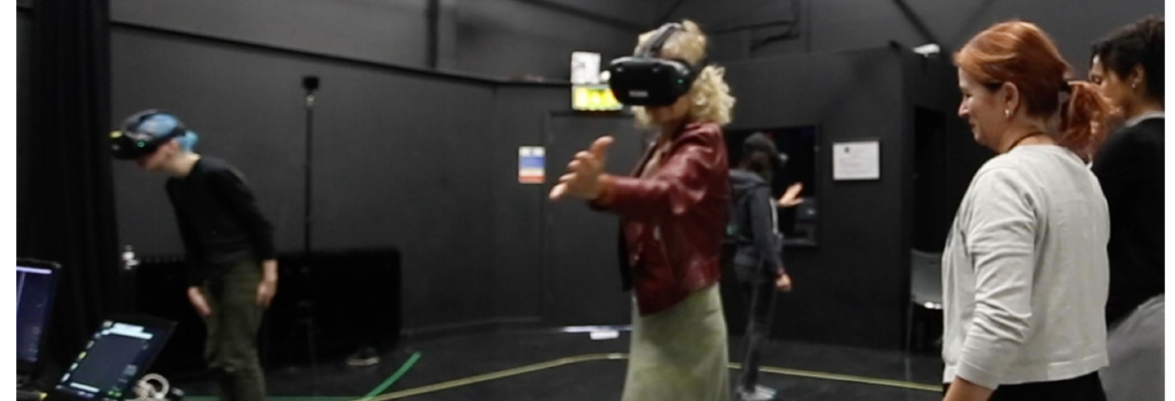
Figure 2. WOSworkshops, BodilyUndoingSymposium, BathSpaUniversity, 2017(thesecondworkshop).